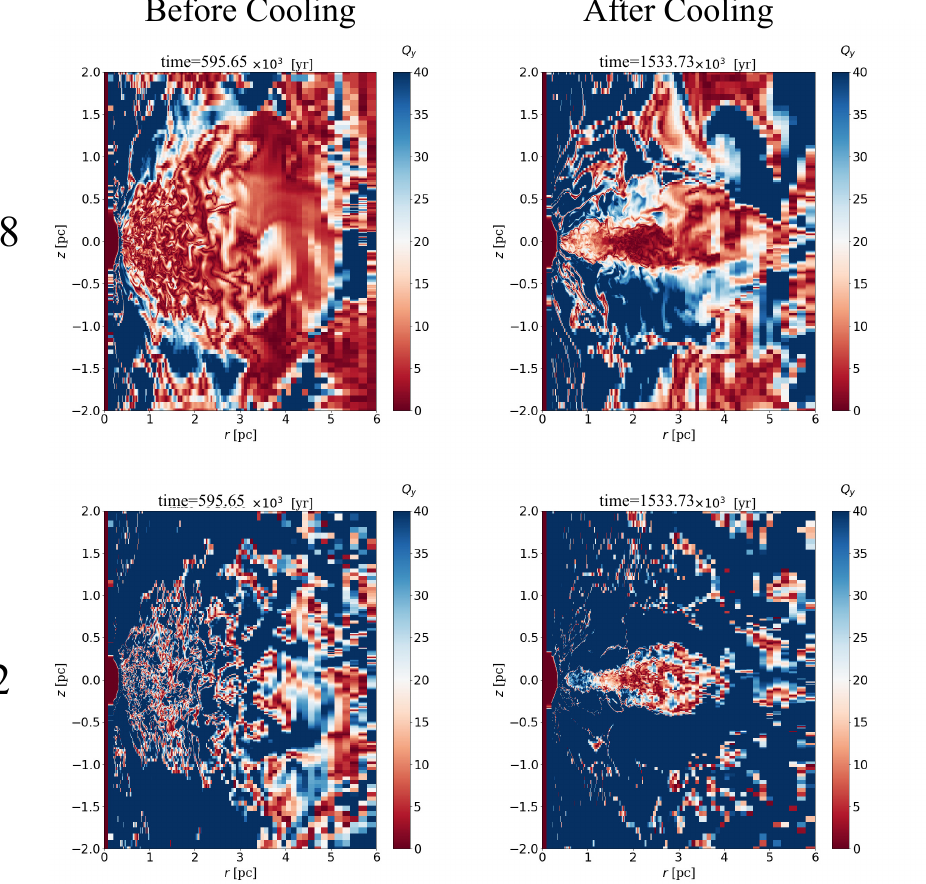
Figure 3. Distribution of Q-value defined as the resolution of typical wave length growing MRI. The left panel denotes the low azimuth-resolution N ϕ = 128, and the right panel denotes the high azimuth-resolution N ϕ = 512. The criteria for resolution is selected by Q ϕ = 20, shown in [25]. Time evolution of azimuthally averaged B ϕ at r = 1 [pc] is shown in Figure 4. Red and blue colors represent that the direction of B ϕ is opposite. Before the heating and cooling tern on ( t < 0.60 [Myr]), the direction of B ϕ is varied from positive to negative inside the torus. This implies that the inner magnetic field escapes buoyantly from the torus in the vertical direction due to Parker